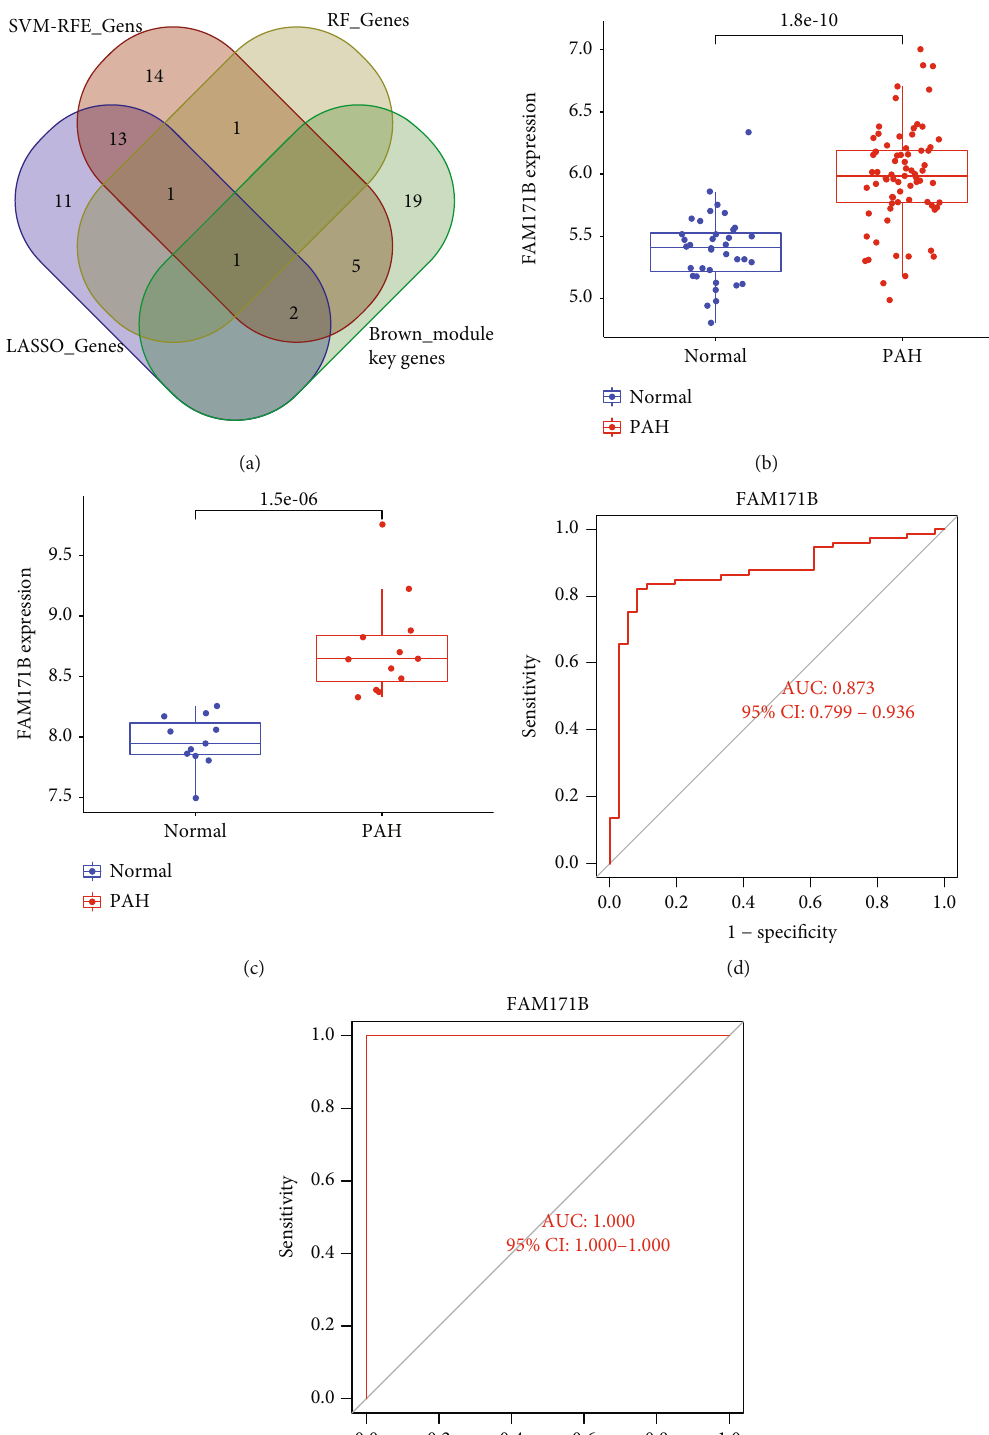
Figure 9: Screening and veri fi cation of diagnostic markers. (a) Venn diagram showing overlapping marker with RF, Lasso, SVM-RFE, and WGCNA. FAM171B mRNA expression is signi fi cantly higher in PAH samples than in normal samples, (b) the combined dataset ( P = 1 : 8e − 10 ) and (c) the GSE53408 ( P = 1 : 5e − 06 ). ROC curves were constructed using publicly available data to assess the diagnostic accuracy of FAM171B for PAH. (d) The combined dataset had an AUC of 0.873. (e) GSE53408 had an AUC of 1. ROC: receiver operating characteristic; AUC: area under the ROC curve; PAH: pulmonary arterial